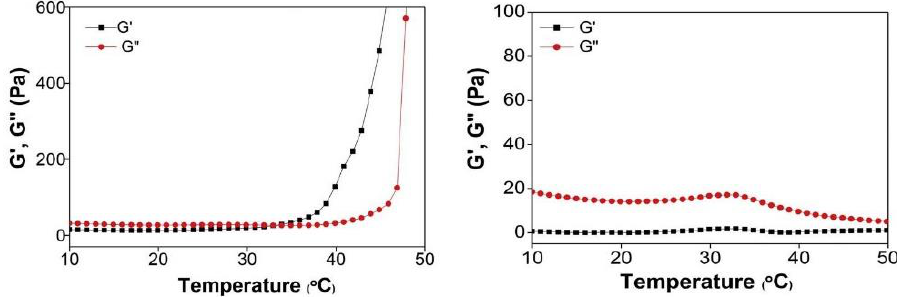
Figure 5. G (cid:48) and G (cid:48)(cid:48) variation with temperature for GCh-C6 (37%) ( left ) and GCh ( right ), at 4 wt% concentration in water. Reproduced with permission from reference [111]. Copyright 2018